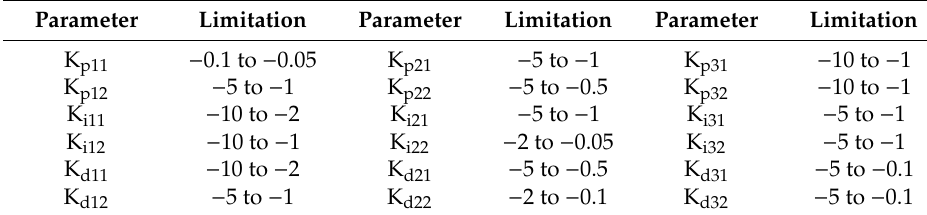
Table 7. The ranges of the parameter